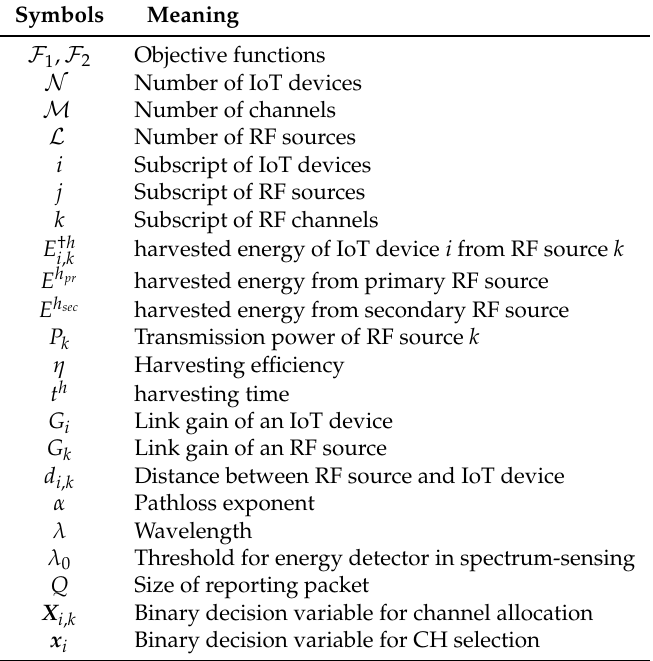
Table 1. Symbols and notations.